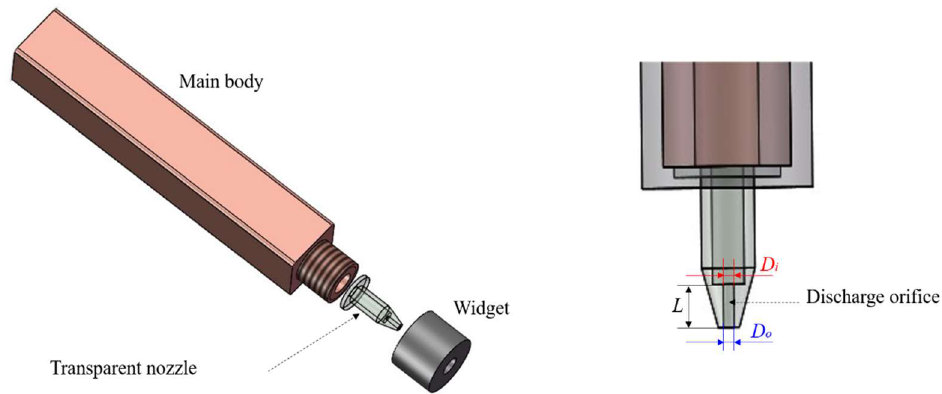
Figure 5. Structure of single injector [21].